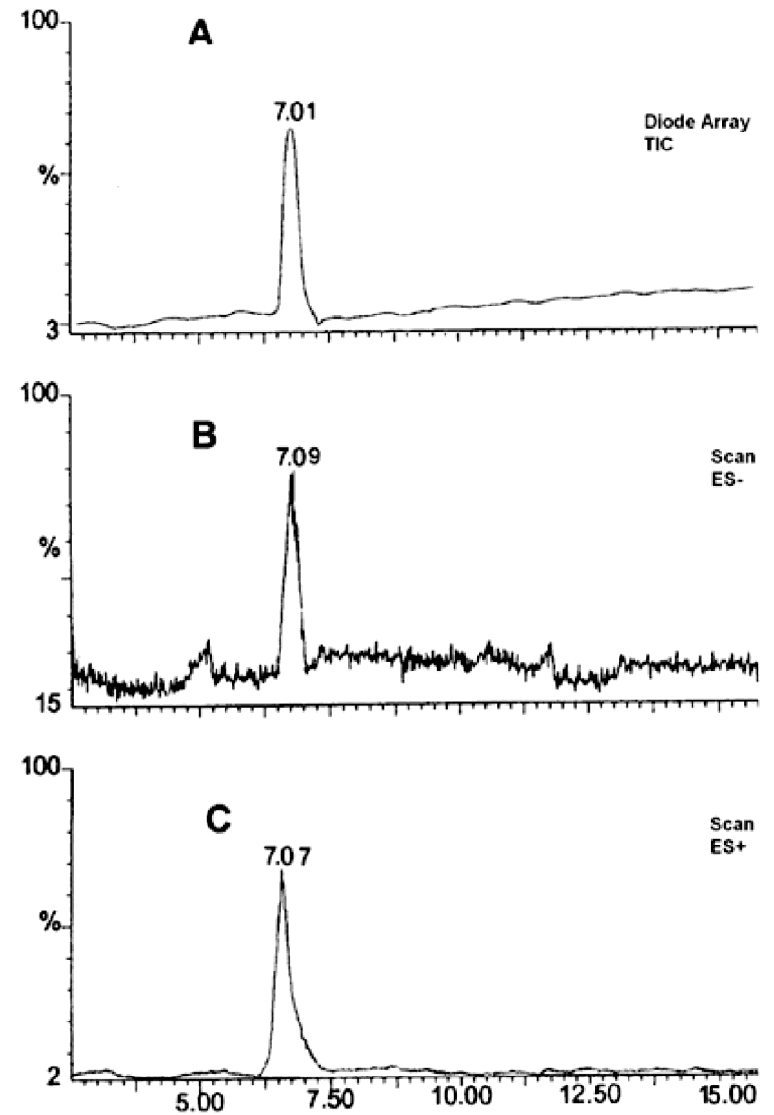
Figure 3. HPLC–ESI(+)-MS-TIC ( A ), HPLC-ESI( − )-MS-Scan ( B ), HPLC-ESI(+)-MS-Scan ( C ). Chromatogram for the analysis of RAM degradation impurity (t = 90 h; 373 K) in solid state.